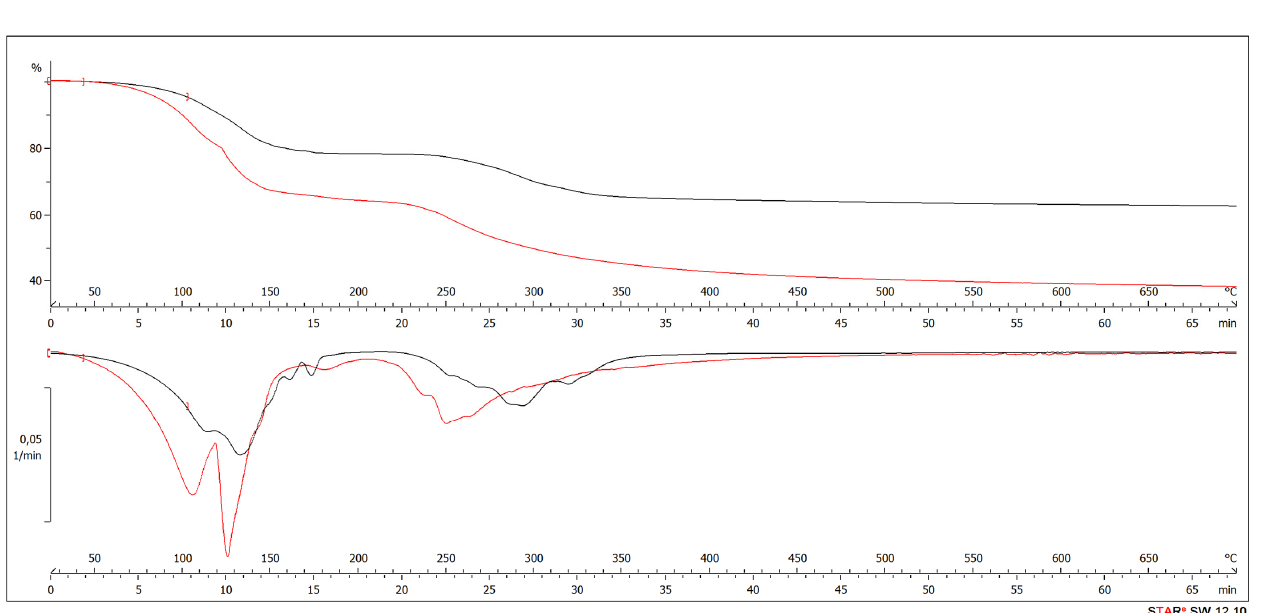
Figure 11. TGA ( top ) and DTG ( bottom ) curves of UF (black) and HDF Type 1 (red) samples.